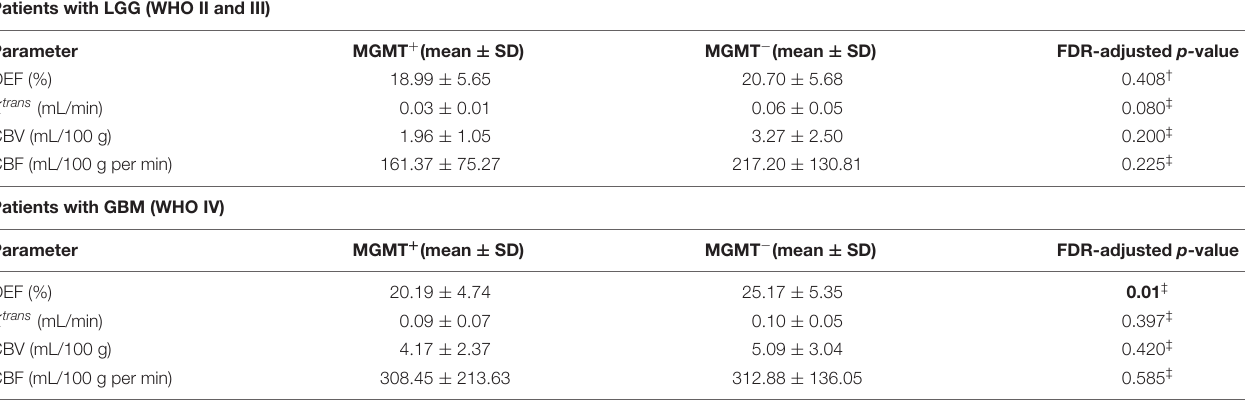
TABLE 3 | Comparison of biomarkers for subgroups of MGMT status. Patients with LGG (WHO II and III)